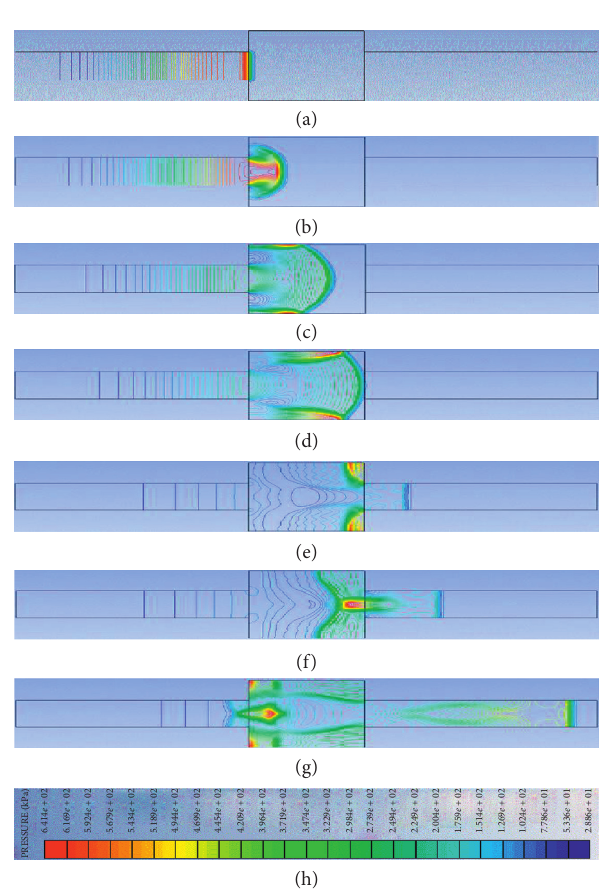
Figure 3: Diagram of overpressure distribution at different mo- ments before and after 500 ∗ 500 ∗ 200 cavity structure. (a) 1ms. (b)